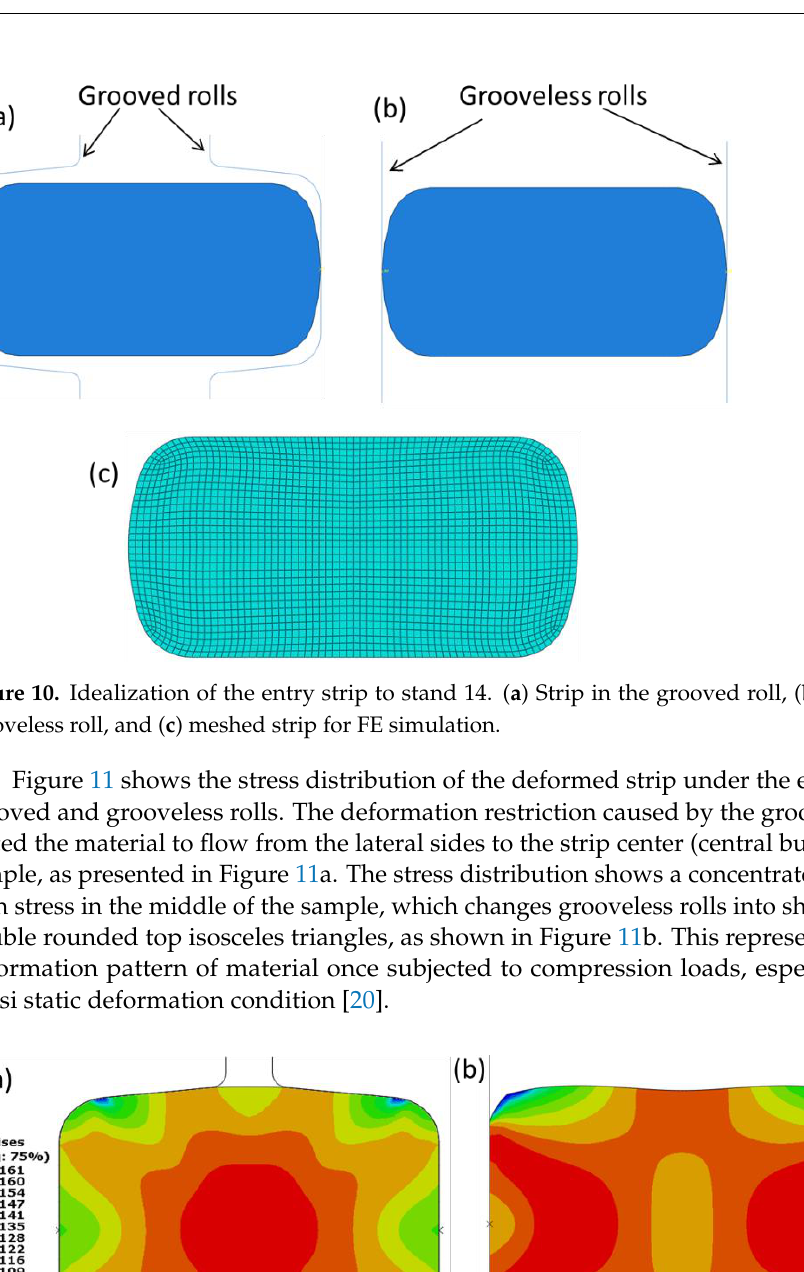
Figure 12. Equivalent plastic strain distribution on the deformed strip after strip deformation by stand 14. ( a ) Strip deformed by grooved rolls, ( b ) strip deformed by grooveless rolls. 4.2. Finite Element Simulations of Preslitting Stand Finite element simulations are executed for single and double barrel (dog bone) as- sembly for investigating the rolling force, torque requirement, power consumption, equiv- alent stress, contact pressure, and equivalent plastic strain, as represented by Figures 13 – 19. The rolling force, 𝐹 of both types of barrels can be estimated by Equation (2) as fol- lows: 𝐹 = 𝜎 𝑓 𝑤𝐿 , (2) where 𝜎 𝑓 is the flow stress, and 𝑤 and 𝐿 are, respectively, the width and contact length of the barrel. The flow stress can be estimated through Equation (3) [21] as follows: 𝜎 𝑓 = 𝐾𝜖 𝑛 1+𝑛 . (3) Here, 𝐾 and 𝑛 are material parameters, which can be extracted from the stress strain curve of material by using linear regression (linear curve fitting) of the data points between 𝑙𝑛(𝜎 𝑓 ) and 𝑙𝑛 (𝜖) . The values of parameters are found as 𝐾 = 195.04 MPa, and 𝑛 = 0.2157 . The contact length, Equation (2), is calculated by Equation (4) [21] as follows: